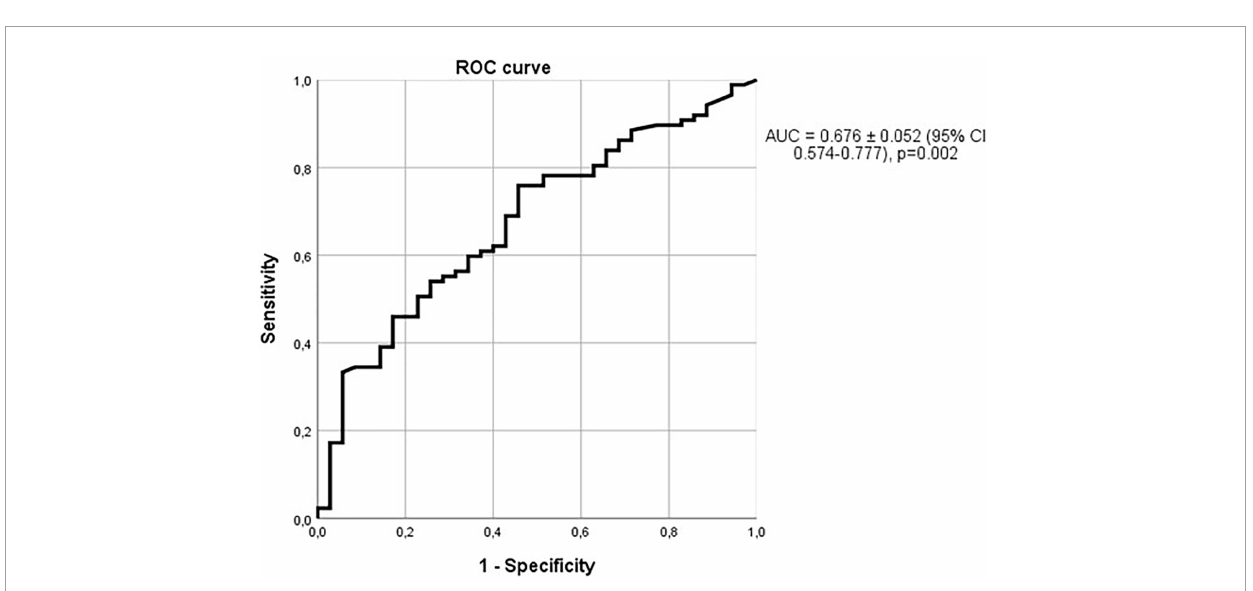
FIGURE5 Relationship of sclerostin with vascular calcifications. ROC curve with an AUC of 0.676 ± 0.052 (95% CI 0.574–0.777); p = 0.002.